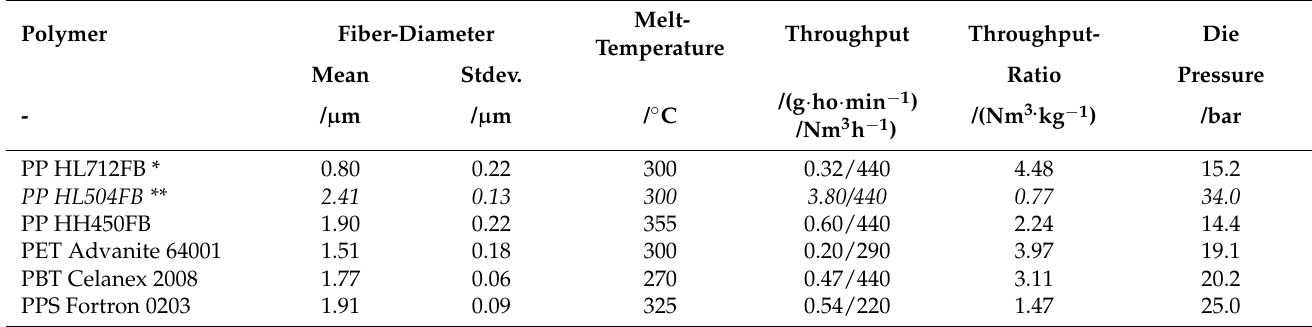
Table 4. Minimal accessed fiber diameters of the processed polymer types and related process